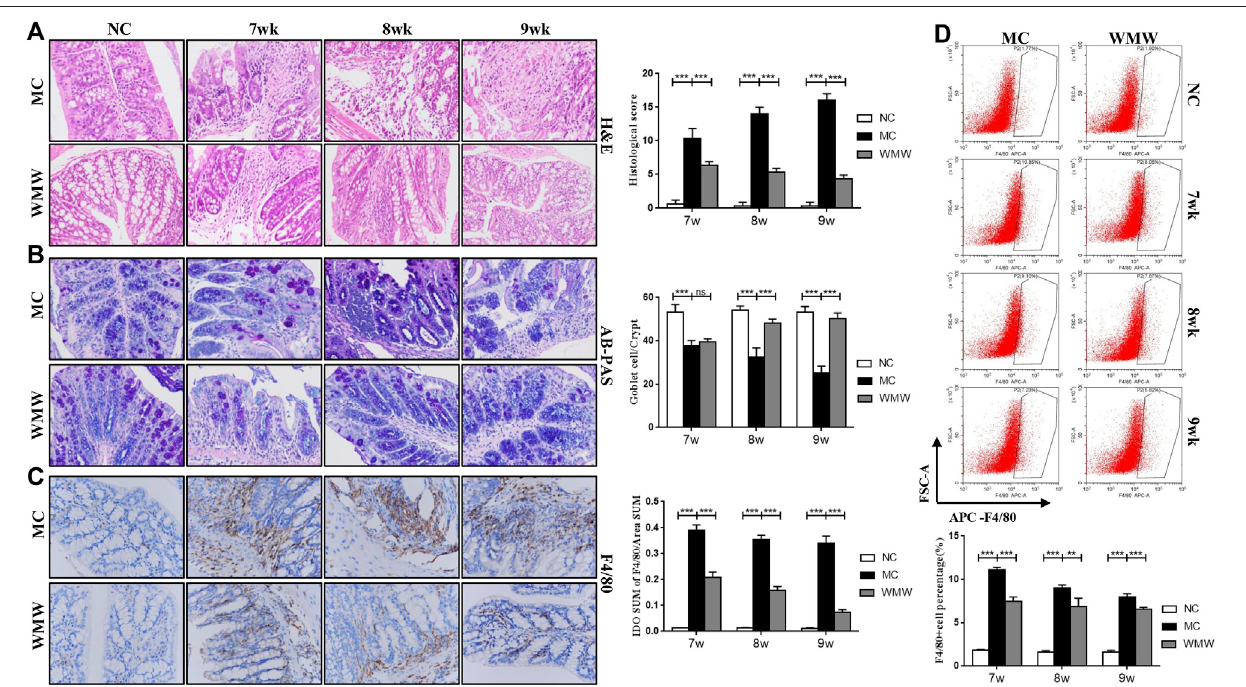
FIGURE4| WMWsigni fi cantlydecrease macrophagein fi ltration and activationandalleviatecolonic tissuedamage. (A) RepresentativecolonH&Estainingand the histological score at different time points of different groups (original magni fi cation, 200 ×). (B) Representative colon AB-PAS staining and the mean number of goblet cells at different time points of different groups (original magni fi cation, ×200). (C) F4/80 Immunohistochemistry in DSS-induced colitis tissue at different groups (original magni fi cation, 400 ×) (D) The proportion of macrophages in mice colon tissues at different time points was detected by fl ow cytometry. n = 3,means ± SEM.* p < 0.05, ** p < 0.01, *** p <